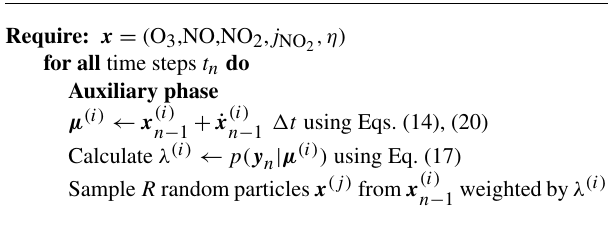
Algorithm 1 Auxiliary particle filter in a O 3 , NO, NO 2 , j NO